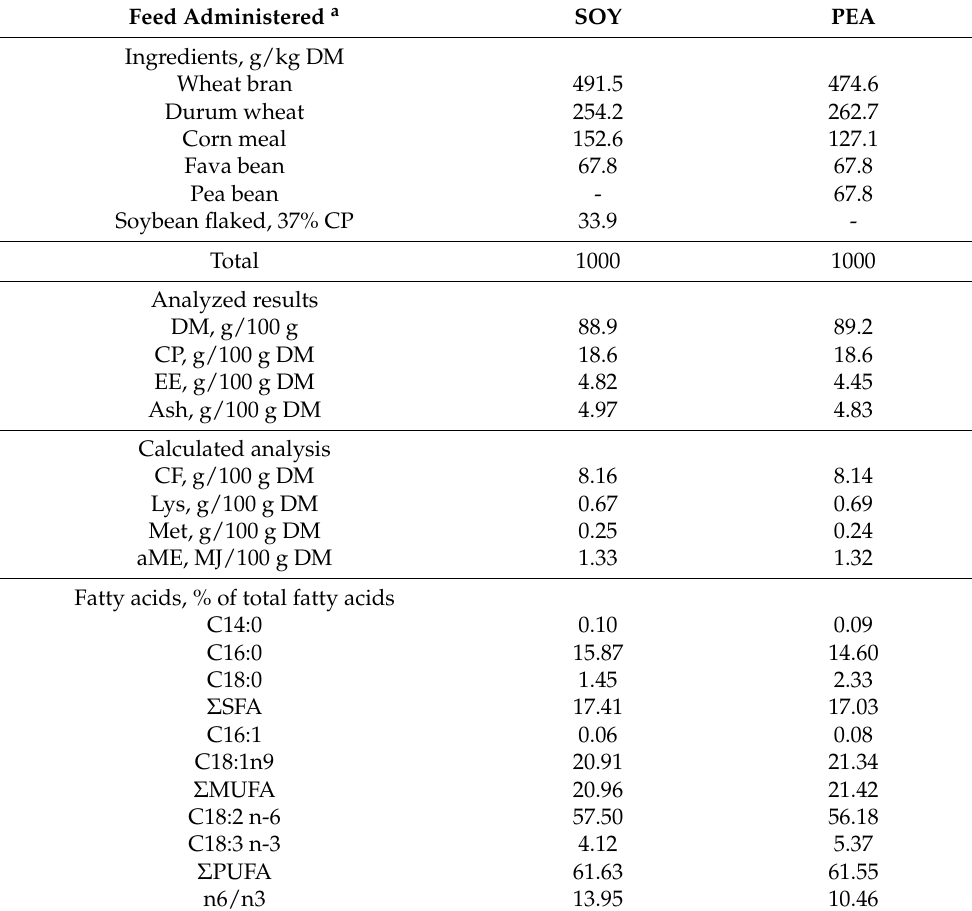
Table 1. Ingredients, chemical composition, energy content and fatty acid composition of the diets. Feed Administered a SOY